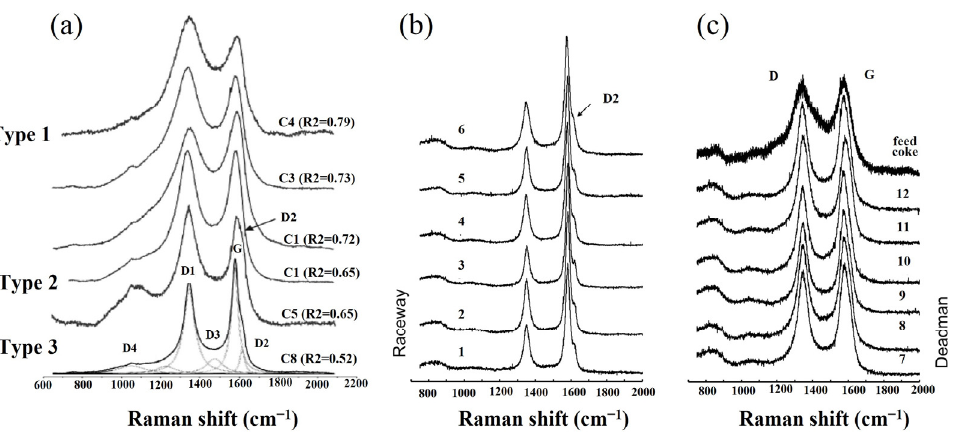
Figure 4. Raman spectra of cokes: ( a ) raw coke from industry [64]; ( b , c ) cokes from different parts of a blast furnace [65].